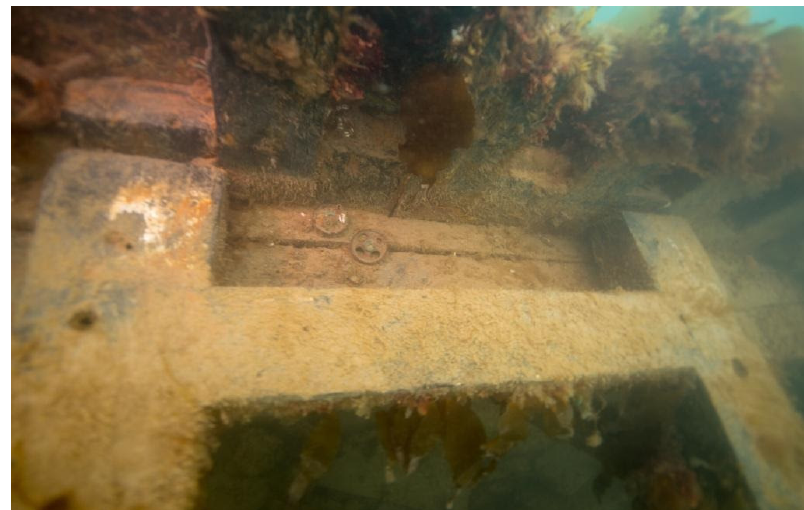
Figure 1. The wrecks of HMS Erebus and HMS Terror sites are protected through the combined endeavours of the local Inuit guardians and the resources of the Canadian state [14].